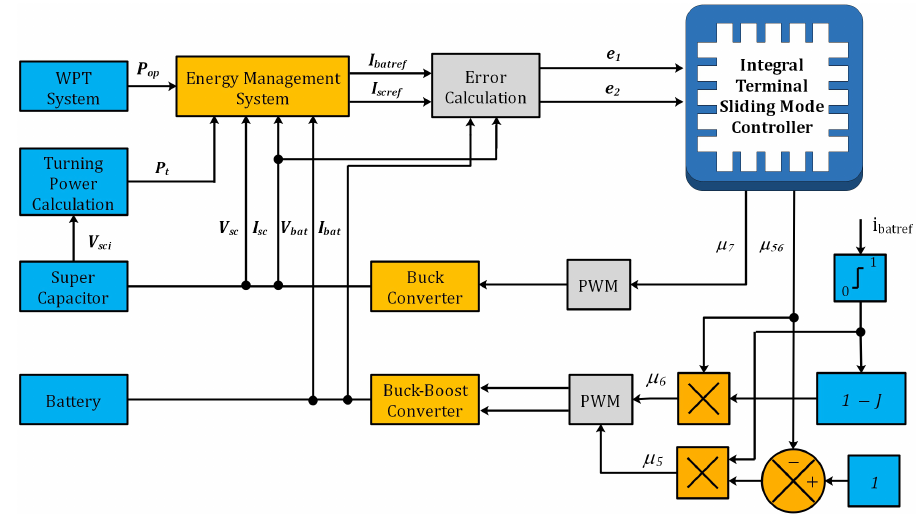
Figure 9. General structure of the controlled system.